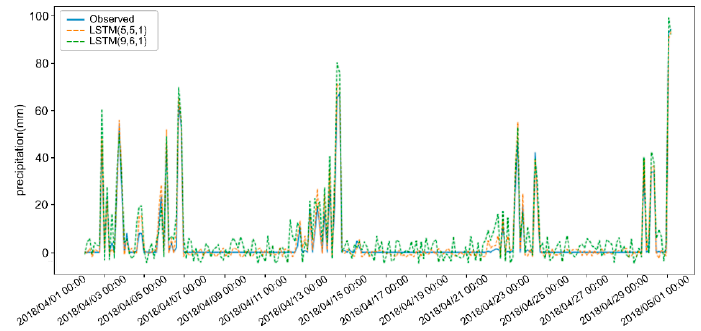
Figure 5. Three-hour precipitation predictions by LSTM (5,5,1) and LSTM (9,6,1).